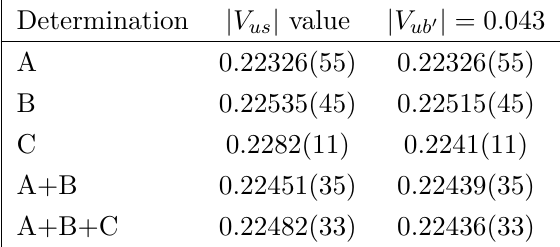
Table 3 . Values of V us obtained from the dataset in eqs. (2.3), (2.5), (2.14). In the first column the SM unitarity of CKM matrix is used, while in the second column the extended unitarity (4.7) is used with | V ub 0 | = 0 . 043